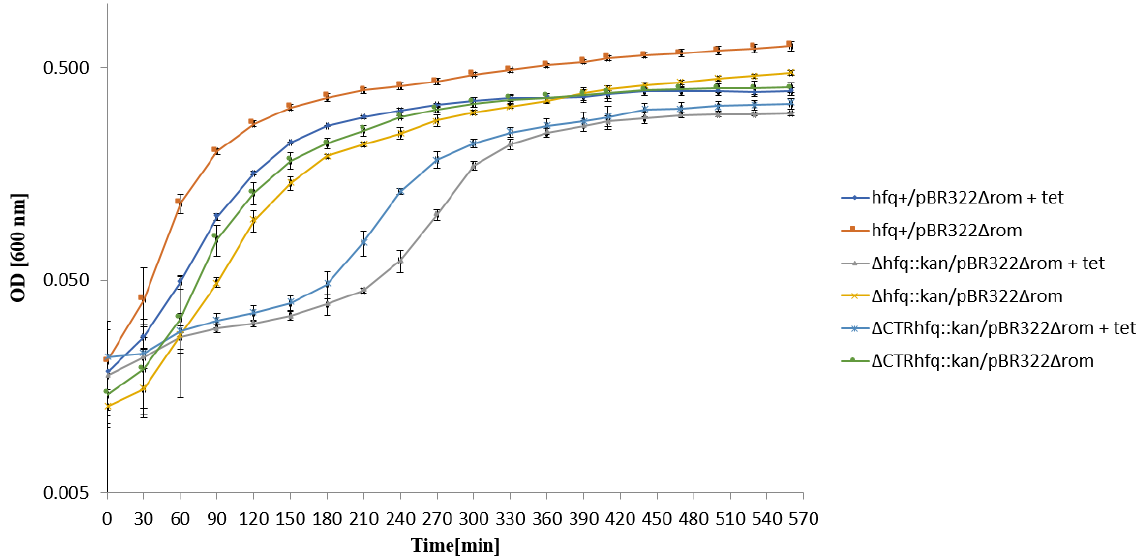
Figure 7. Growth of E. coli strains hfq + , Δ hfq :: kan , and Δ CTR hfq :: kan bearing plasmid pBR322 Δ rom in the LB liquid medium containing 68 μ g/mL tetracycline (+tet) or devoid of this antibiotic (no mark) at 37 °C, after transferring bacteria from antibiotic-free LB and diluting the culture 10 times in a fresh LB medium (with or without tetracycline) at time 0. The presented data indicate mean values from three independent experiments with error bars showing SD. Minimal inhibitory concentrations (MIC) of tetracycline for hfq + , Δ hfq :: kan , and Δ CTR hfq :: kan hosts bearing pBR322 Δ rom under these conditions were 256, 128, and 128 μ g/mL, respectively.